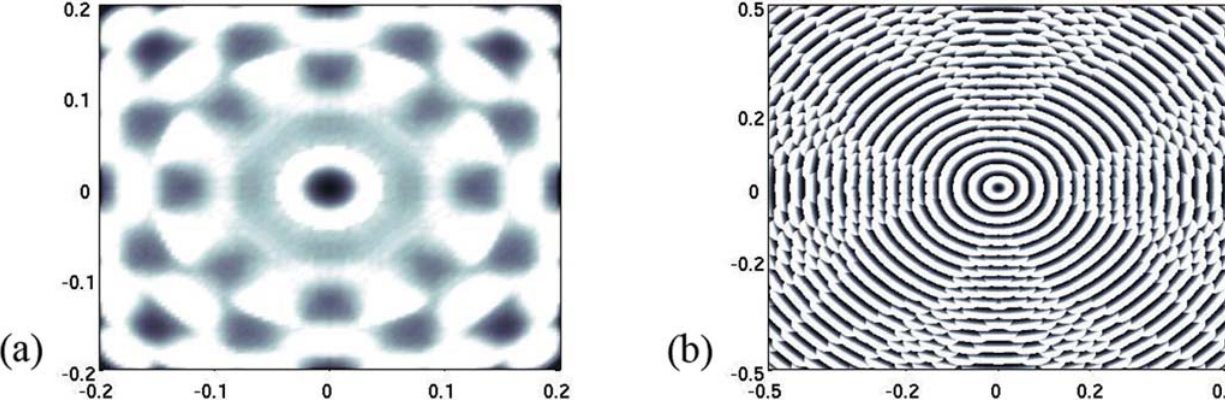
Figure 3. Apparition of concentric patterns under the preconditioning model (1)-(2). The protection factor is given by Heaviside function P ( w )=( q 2 w ) + with a given threshold q . (a) We have replaced the preconditioning equation (2) with w = K * d , the kernel K being a stiff Hill function with p a ffiffi e range of action, K ( z ) ~ 1 z j j ƒ ffiffi e p . Other parameters are e =0,4 and q =0,1. Interestingly the range of action of the potential w is larger than in figure 5 whereas the size of the domain is considerably smaller. In fact, this range fully determines the width of the bands. (b) Same illustration with a degenerated potential w ( x ) ~ max z j j ƒ ffiffi e p d ( x z z ), q ~ 0,8, e ~ 0,1 . Destroyed oligodendrocytes are figured in black. The size of the domain is four times smaller than in figure 4 (axis labels in cm s), whereas the action range is similar. doi:10.1371/journal.pone.0000150.g003 PLoS ONE |